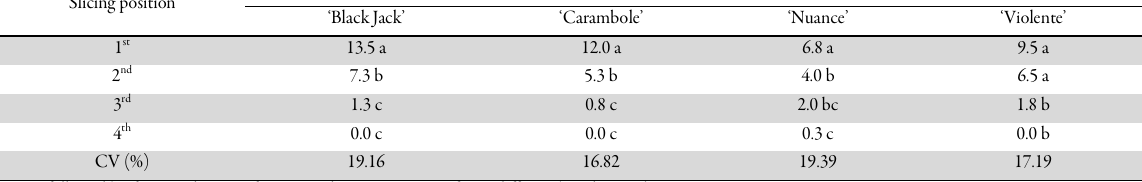
Table 4. Interaction effect of slicing positions and responses of varieties on number of leaves per explant Slicing